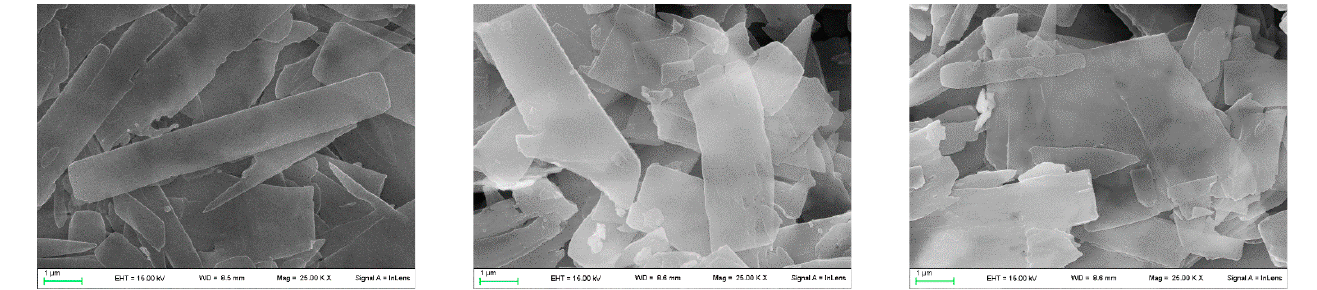
Figure 4. From the left: SEM images of pristine γ ZP, γ ZP05, and γ ZP1. As for the composites based on α ZP, the particles are similar in size and morphology to the pristine ZP. Again, the morphology was retained after ion exchange with ALN groups to yield hybrid α ZP. The images showed small, irregularly shaped platelets with a size lower than 1 μ m (Figure 5).